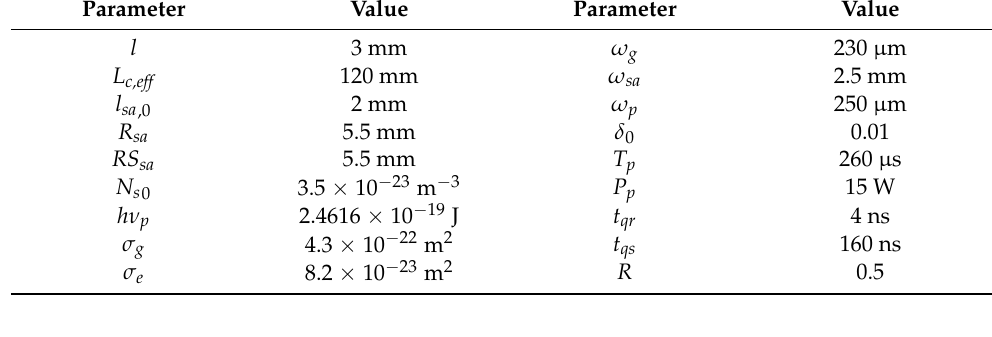
Table 1. Parameter values used in the theoretical simulations.